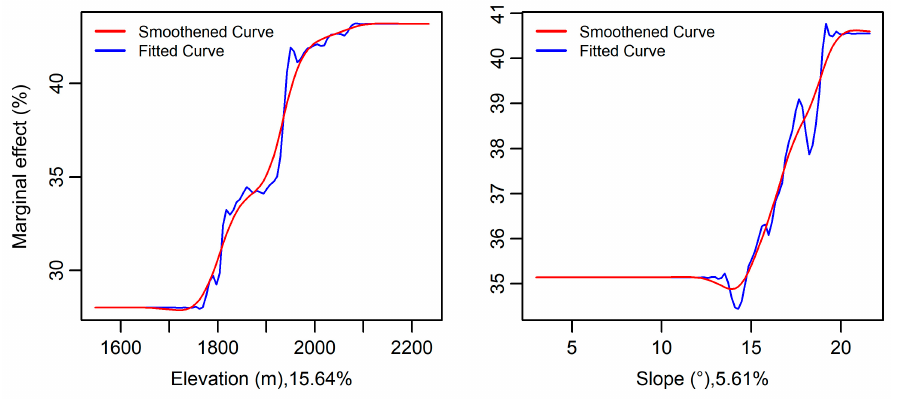
Figure 8. The relationships between topography and RPI.